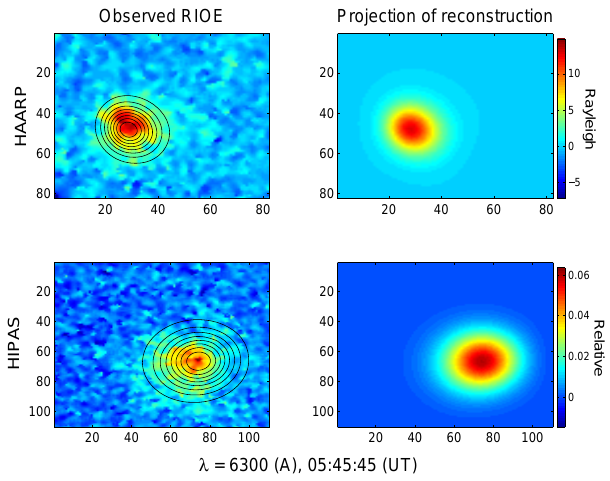
Fig. 6. This figure shows the image regions with the enhanced emissions at 5577 ˚A. In the top row left panel the observed HAARP image is overlaid with contour lines from the projection of the mod- eled emissions, from Eq. (1), with the optimal parameters from Eq. (6). The top right panel displays the projection of the modeled image as seen from the HAARP site. The bottom left panel shows the observed image from HIPAS, overlaid with contours of the pro- jection of the modeled emission. The bottom right panel shows the projection of the modeled emission as seen from HIPAS.